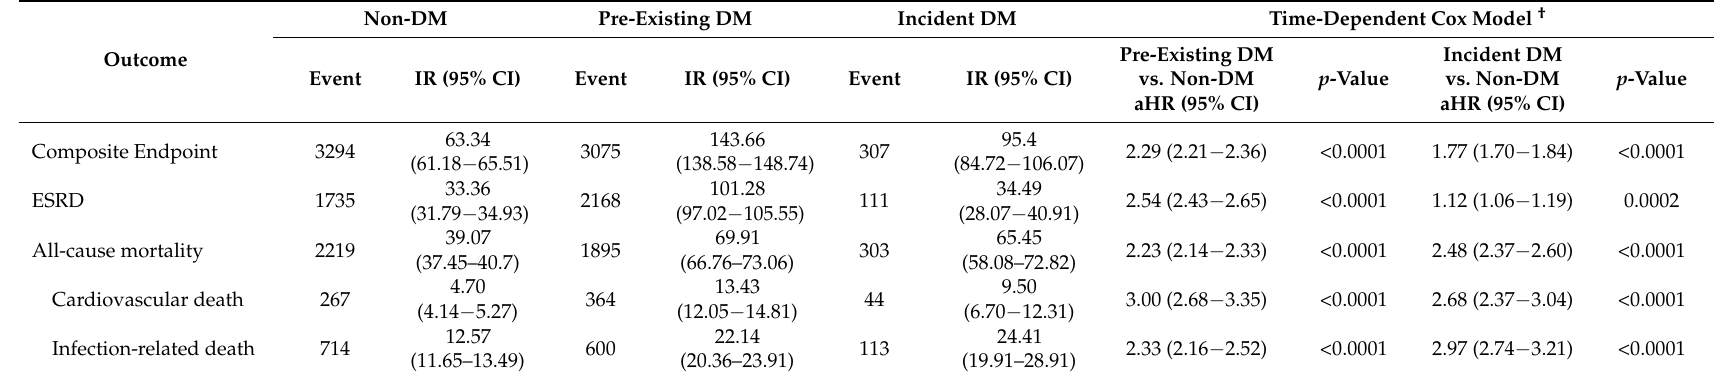
Table 2. Risks for composite endpoint (ESRD or mortality), ESRD and mortality among patients with CKD by DM